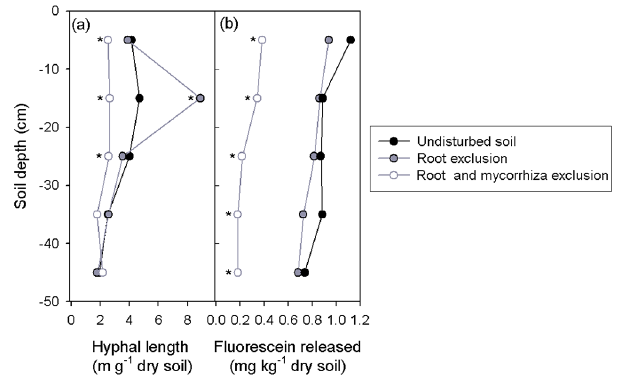
Figure 4. (a) Mean hyphal length (mg − 1 dry soil) and (b) mean microbial activity expressed as fluorescein released (mgkg − 1 dry soil) in the undisturbed soil, root exclusion and root and mycor- rhiza exclusion in different soil depths. Asterisks denote significant differences from undisturbed soil determined by the Tukey honest significant difference